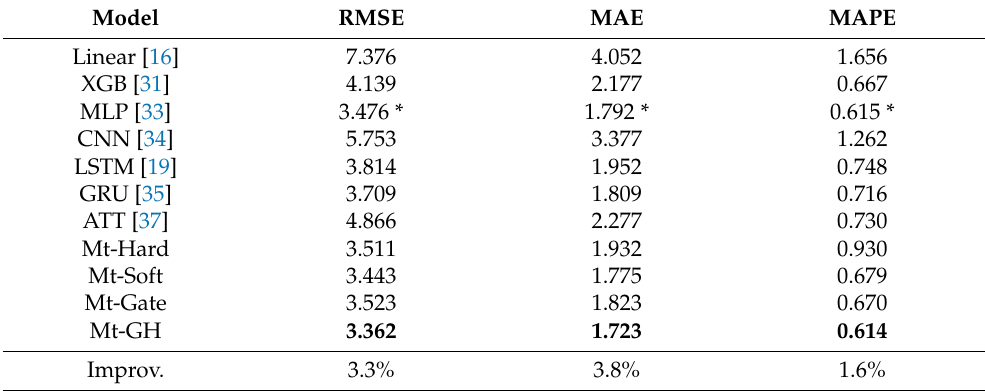
Table 7. The performance comparison of tower structures in the Multi-Task-GH model.